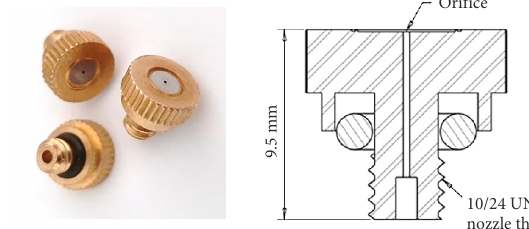
Table 1. Condition of medical garment at various moisture